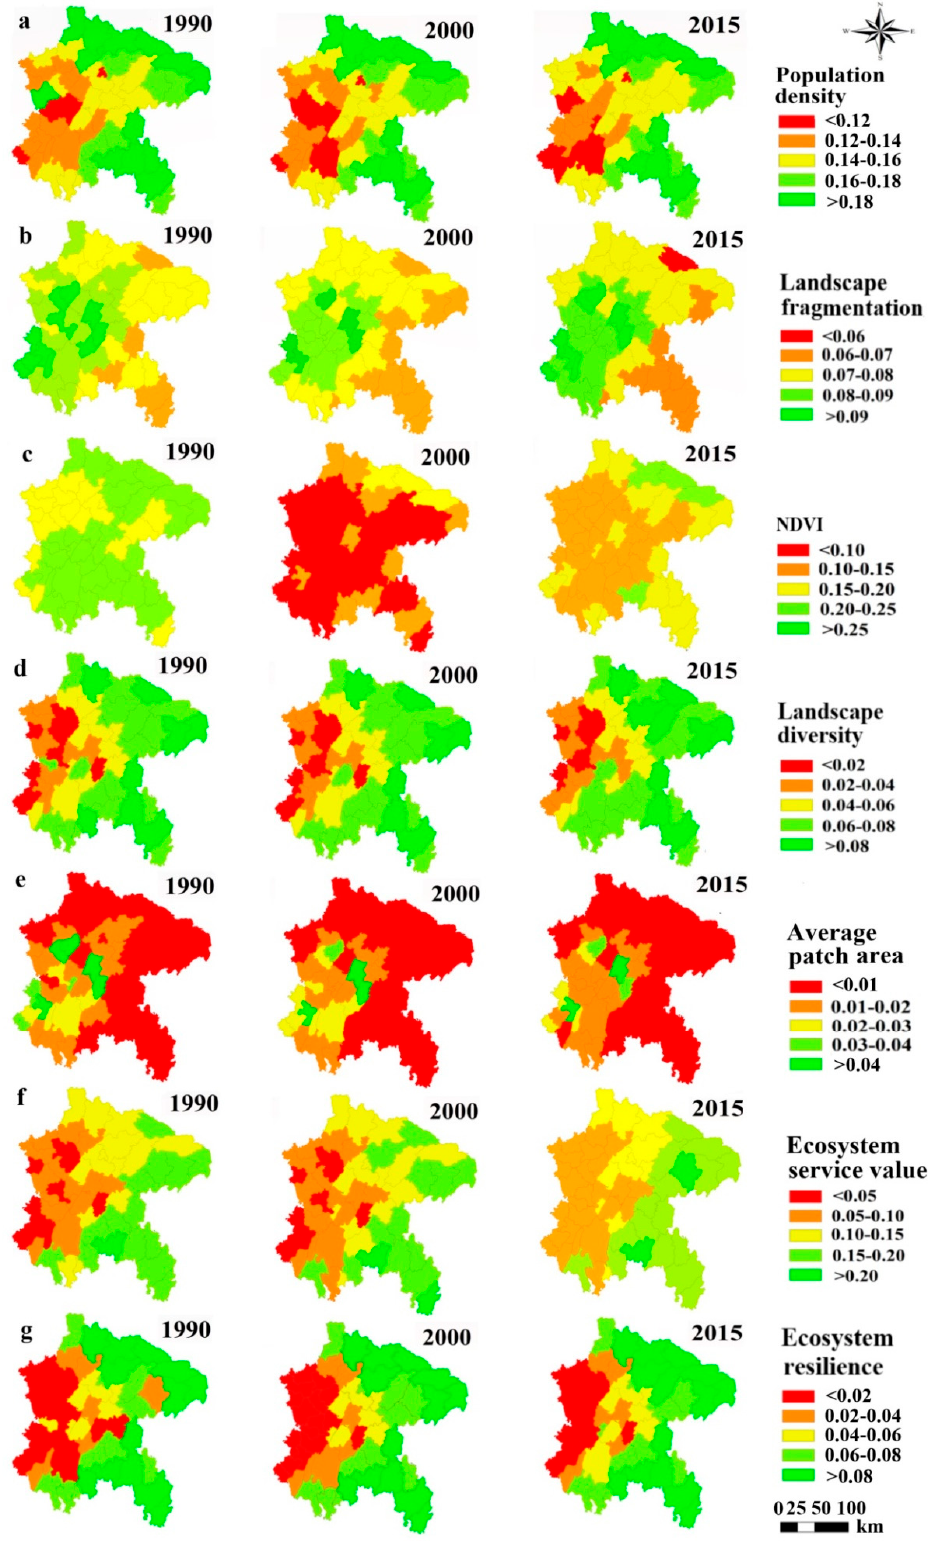
Figure 7. The spatial distribution of different indices at the county level based on standardized data for the years 1990, 2000 and 2015: ( a ) PD; ( b ) LFI; ( c ) NDVI; ( d ) LDI; ( e ) APAI; ( f ) ESV; ( g ) ER.